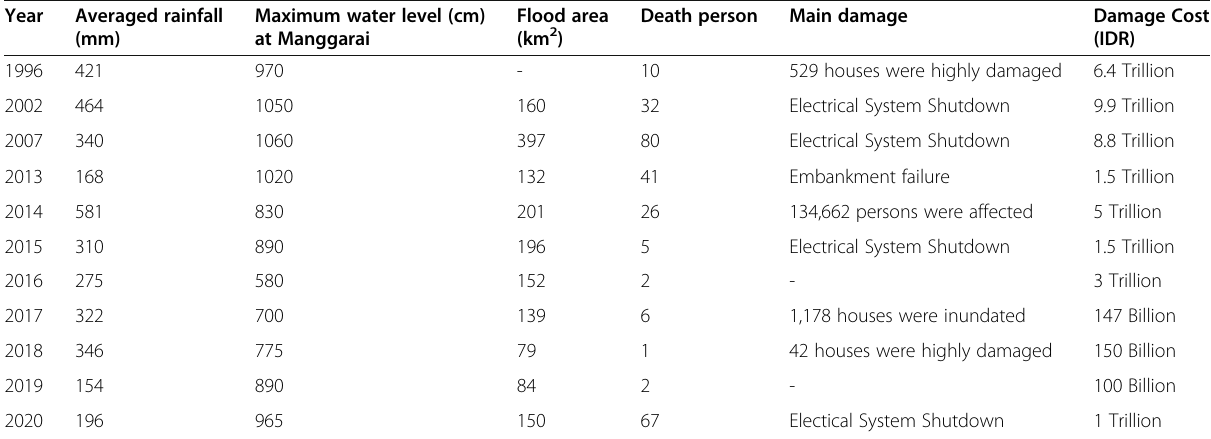
Table 1 Summary of historical flood